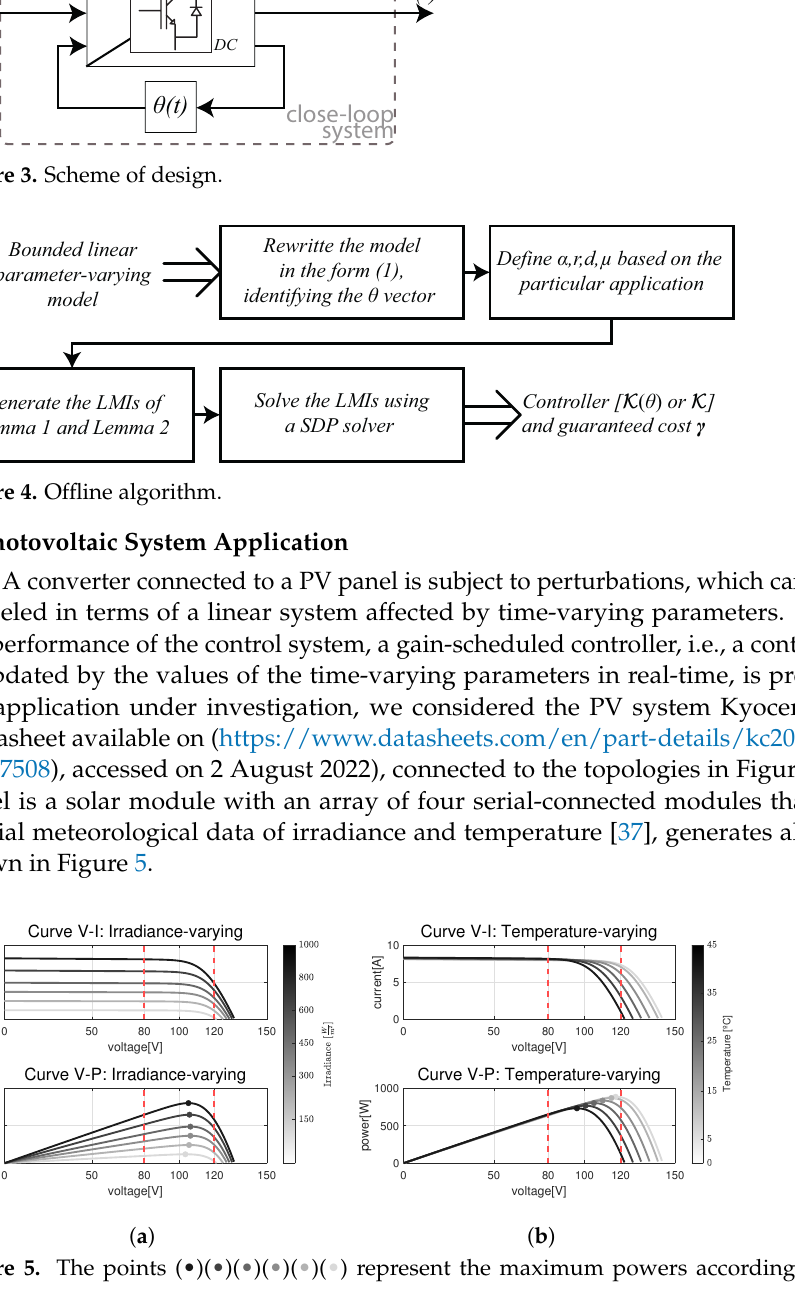
Figure 5. The points (•)(•)(•)(•)(•)(•) represent the maximum powers according to each case. ( a ) Irradiance curves for constant temperature of 25 °C. ( b ) Temperature curve for a constant irradiance of 1000 Wm − 2